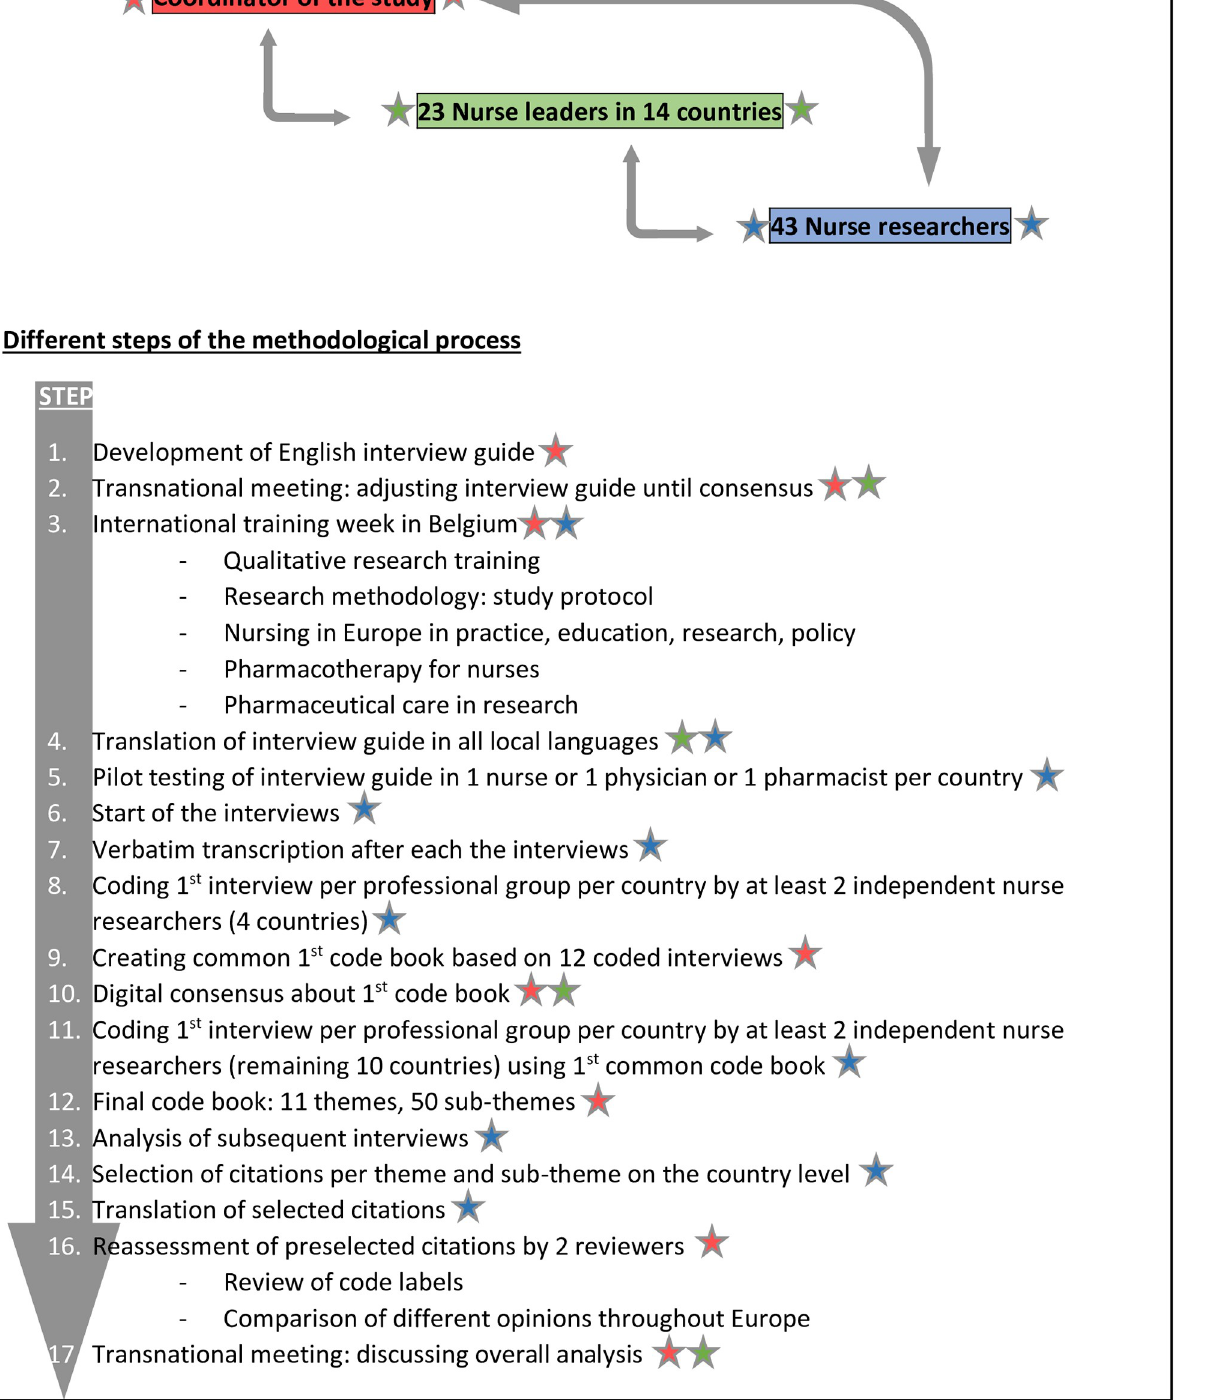
PLOS ONE | https://doi.org/10.1371/journal.pone.0251982 May 27,